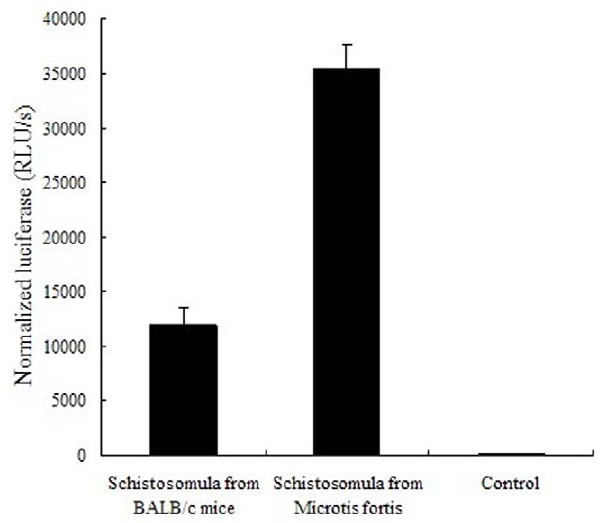
Figure 6. Caspase activity analysis. The caspase activity in schistosomula from BALB/c mice and Microtus fortis show the mean and standard error derived from triplicate experiments.